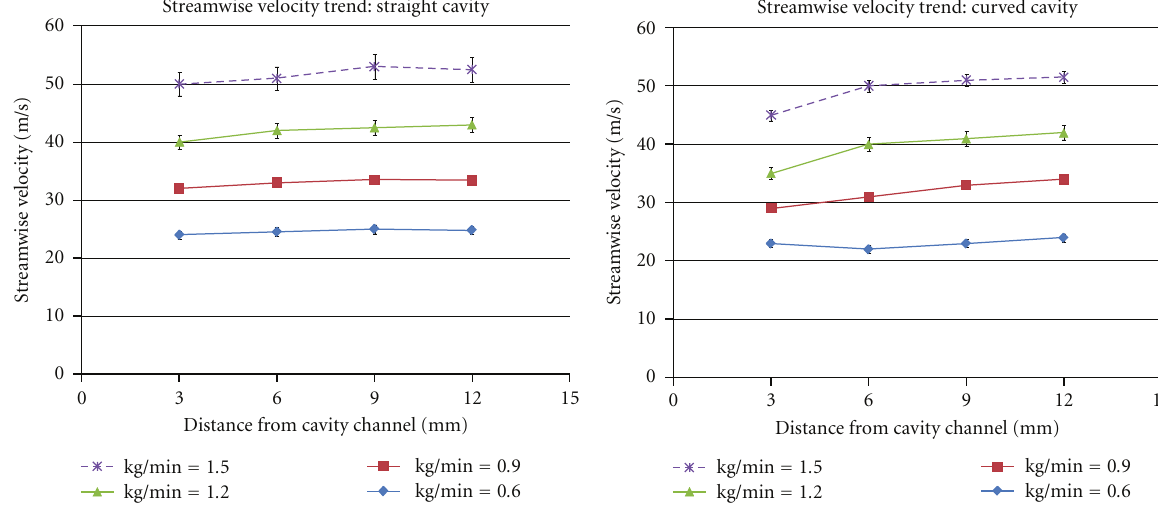
Figure 13: Mean streamwise (U) velocity as a function of depth within the main channel.